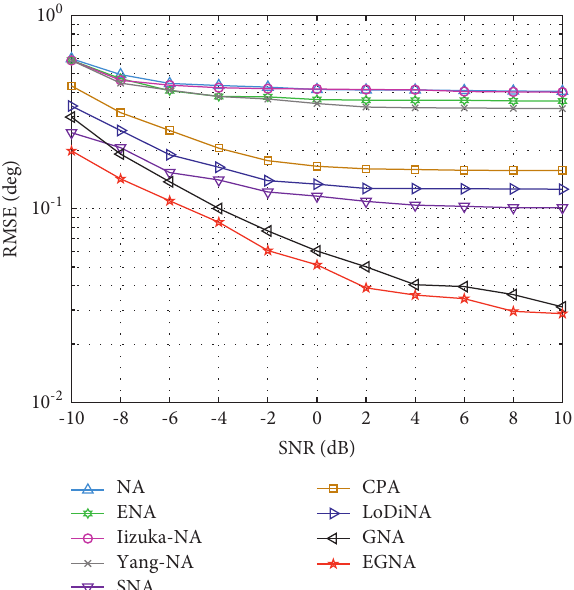
Figure 10: RMSE versus SNR for different array geometries.